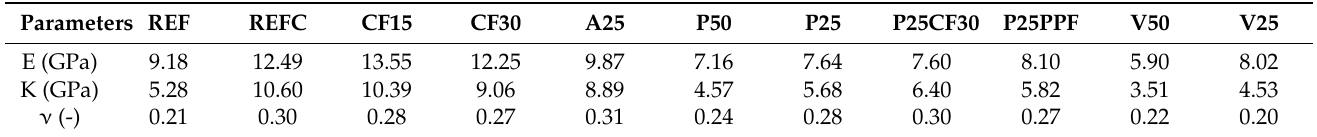
Table 3. Mechanical properties of multiscale porous lime-cement mortars by ultrasonic pulse trans- mission technique (adapted from